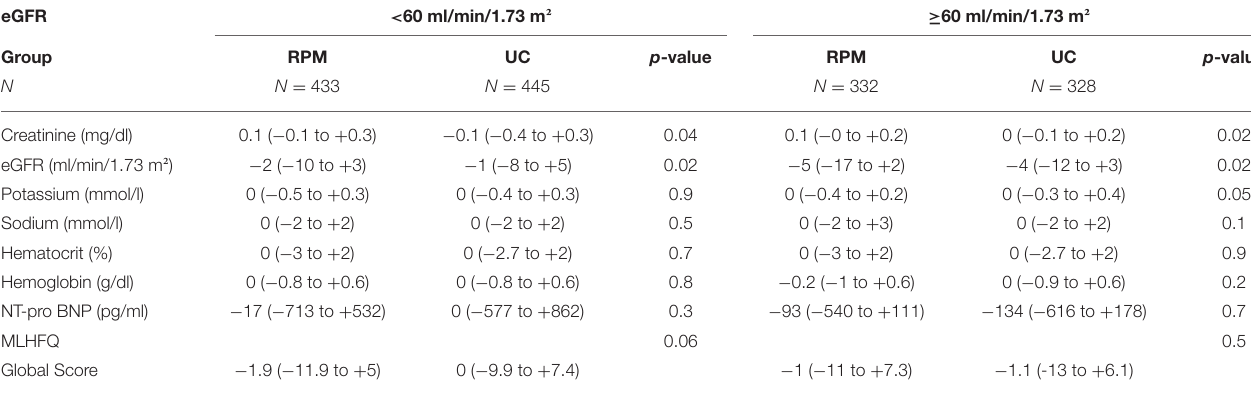
TABLE 5B | Comparison of lab values and MLHFQ from baseline to end of observation (last carried forward) according to the treatment arm. eGFR < 60 ml/min/1.73 m ² Group